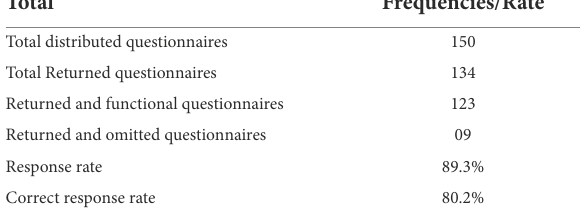
TABLE 1 Response rate for the